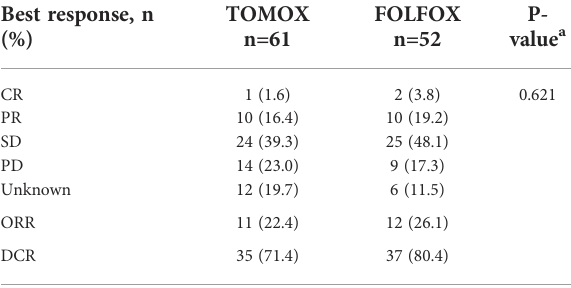
recommended third-line systemic therapy. TAS-102 has been reported improve median OS from 5.3 to 7.1 months and median PFS from 1.7 to 2.0 months (26, 27). CORRECT and CONCUR reported that regorafenib versus placebo improved